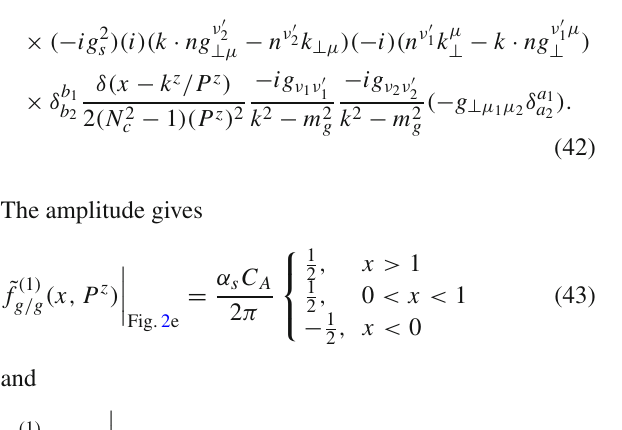
Figure 3b leads